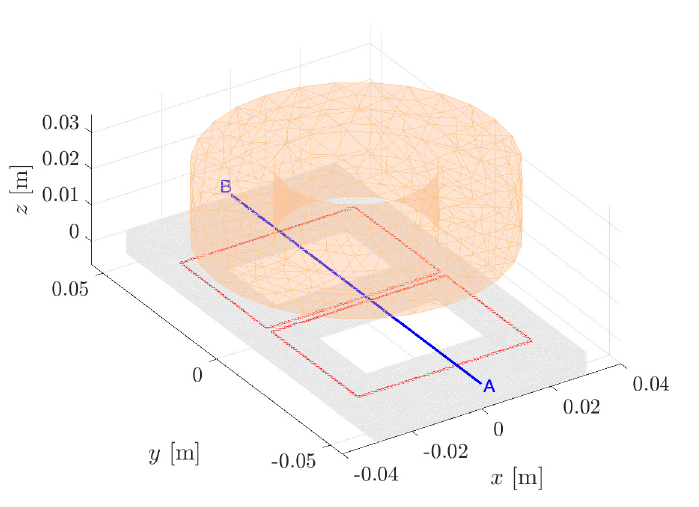
Figure 8. TEAM 3 Problem: an aluminum plate with two symmetric holes excited by current driven coil (orange); virtual loops are depicted in red and the field calculation line AB is depicted in blue. The same numerical tests as in the axisymmetric inductor benchmark were